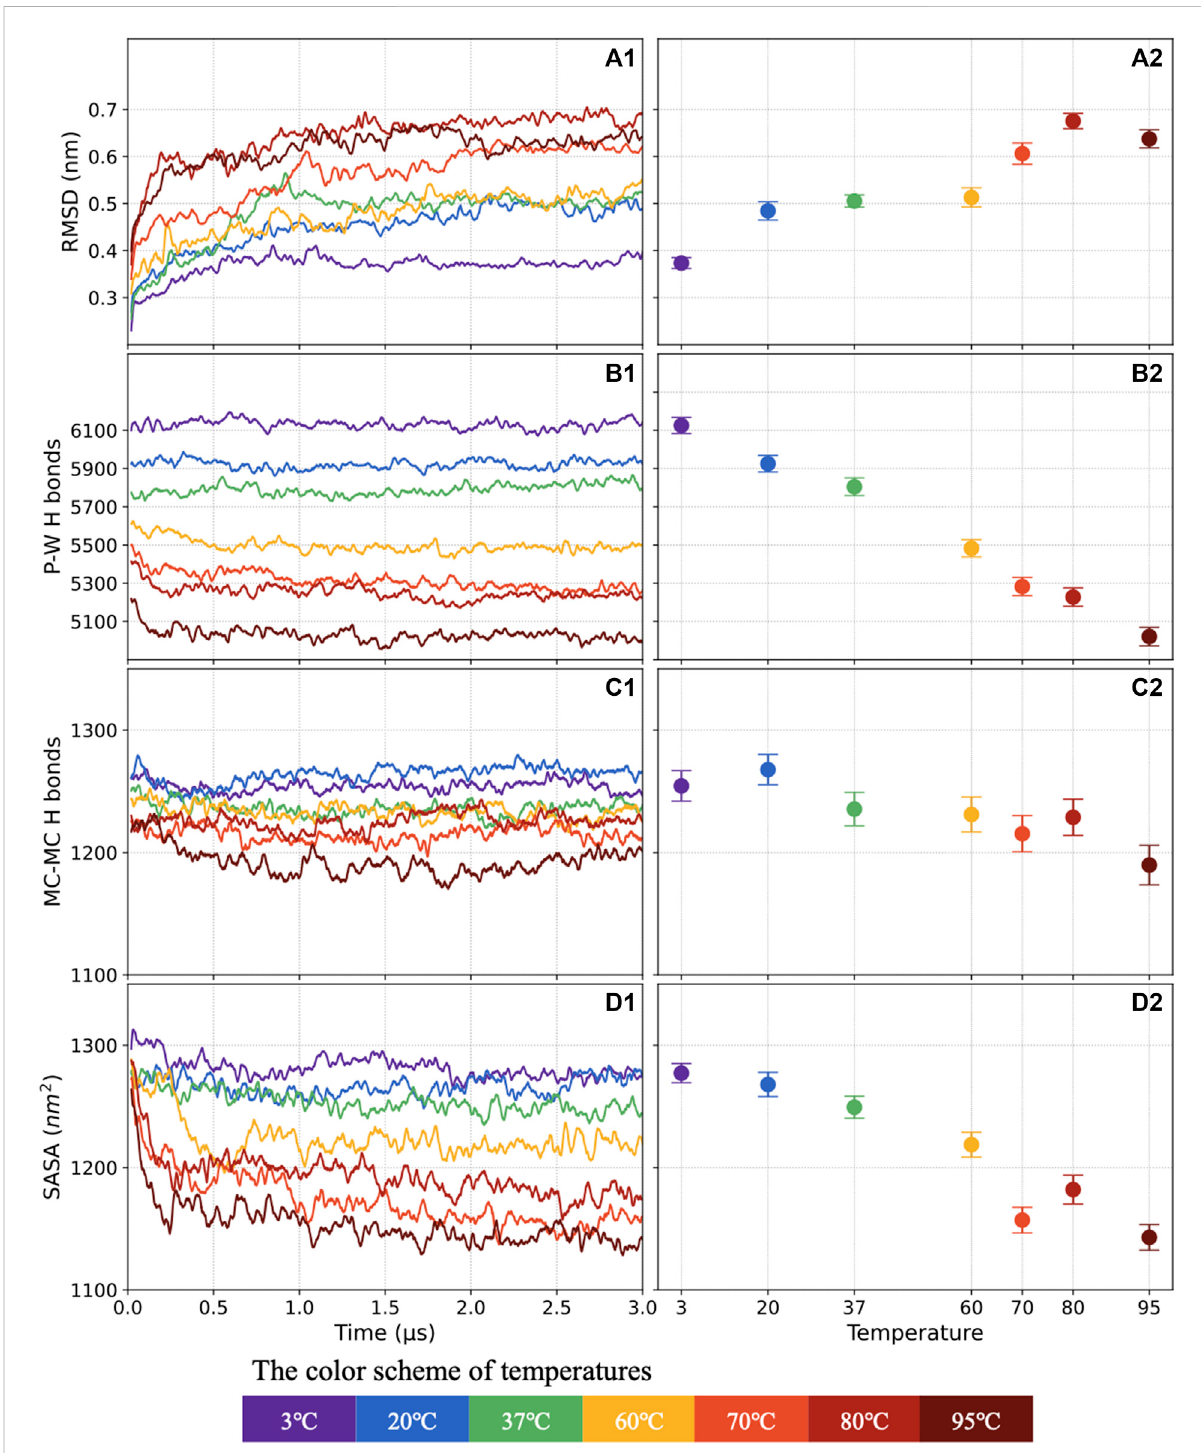
FIGURE 3 The RMSD evolving as a function of time (A1) and average distribution of the last 1.5 μ s values (A2) . Similar plots show the number of P-W H-bonds (B1,B2) , the numbers of M-M H-bonds (C1,C2) , and the SASA (D1,D2) . This manuscript will keep using the color scheme for 3 ° C – 95 °